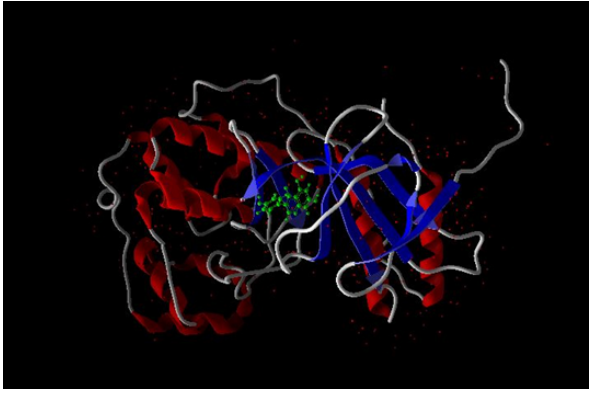
Fig. 9. Genistein (green ligand) inserted in the functional sites of